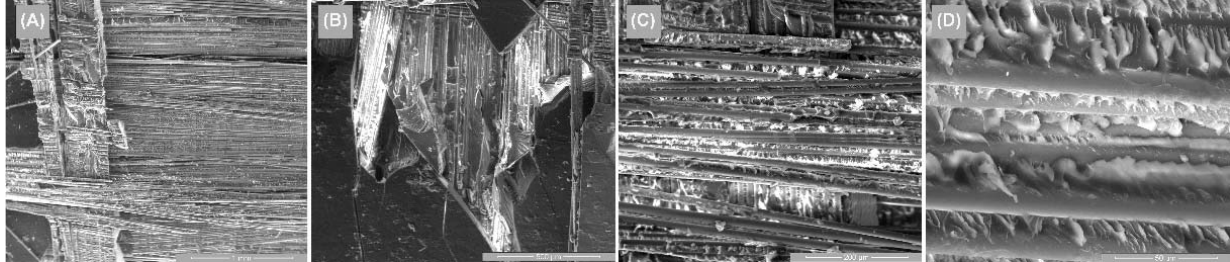
Figure 15. Surface SEM images of oriented at 45 GFRP sample: ( A ) 100×, ( B ) 200×, ( C ) 500×, and ( D ) 2000×.